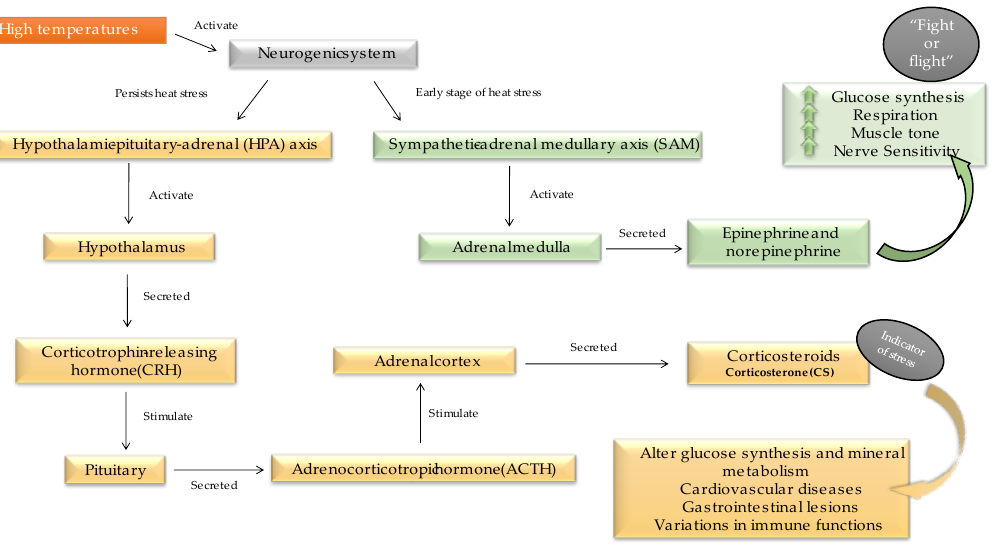
Figure 2. Physiological response triggered in the early stage of heat stress (green part) and persistent heat stress (yellow part) and what implications can be caused by each when poultry are subjected to high temperatures.